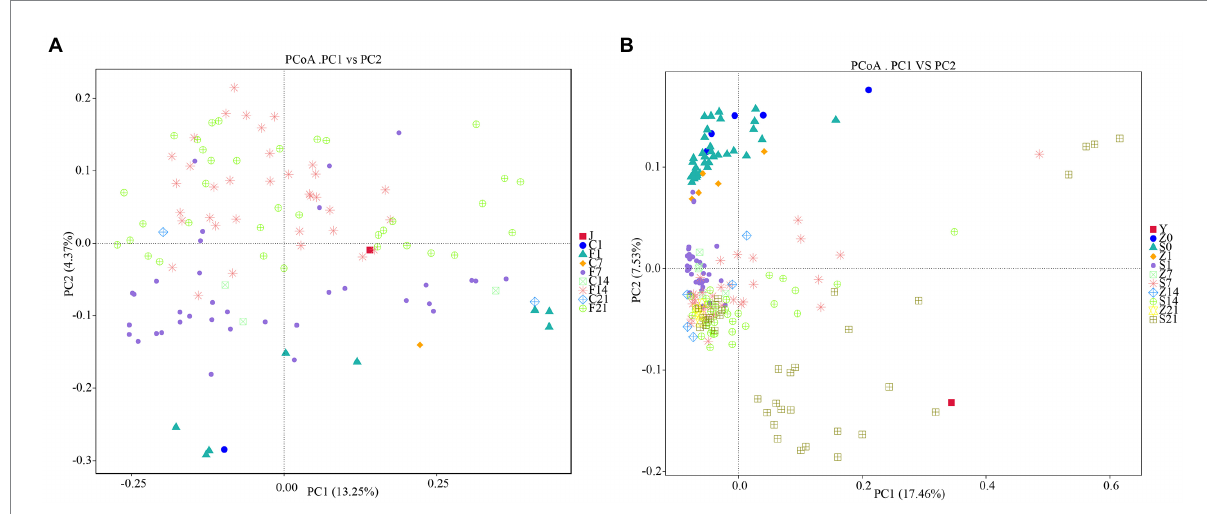
FIGURE 4 Principal coordinates analysis based on unweighted_unifrac distance. (A) PCoA analysis in GF mice; (B) PCoA analysis in SPF mice. GF, germ-free; PCoA, principal coordinates analysis; SPF, specific pathogen